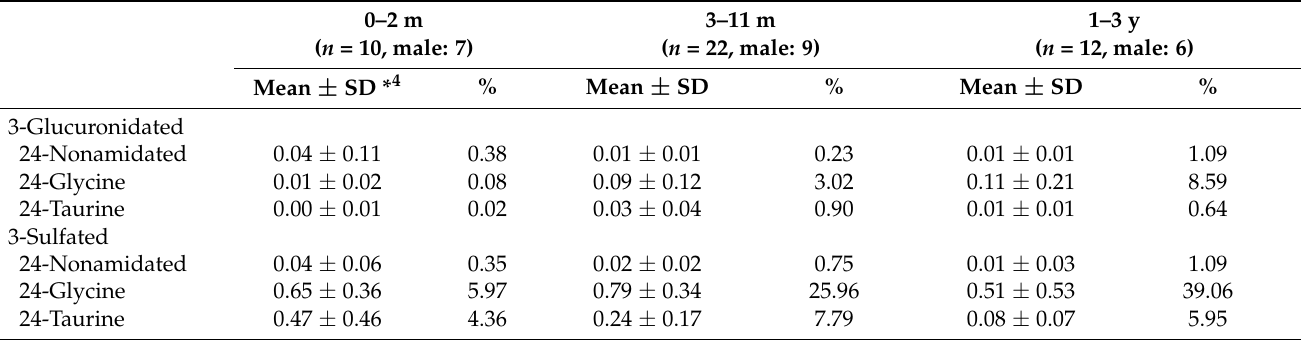
Table 1. Age-dependent changes in the forms of bile acids excreted in the urine * 1